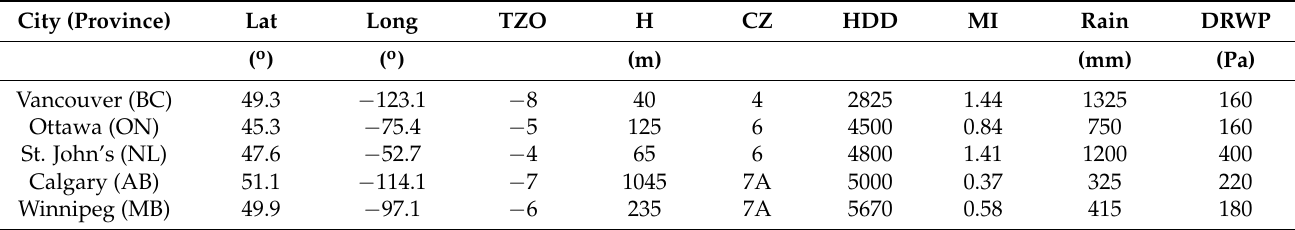
Table 1. Location and climate design data of the selected